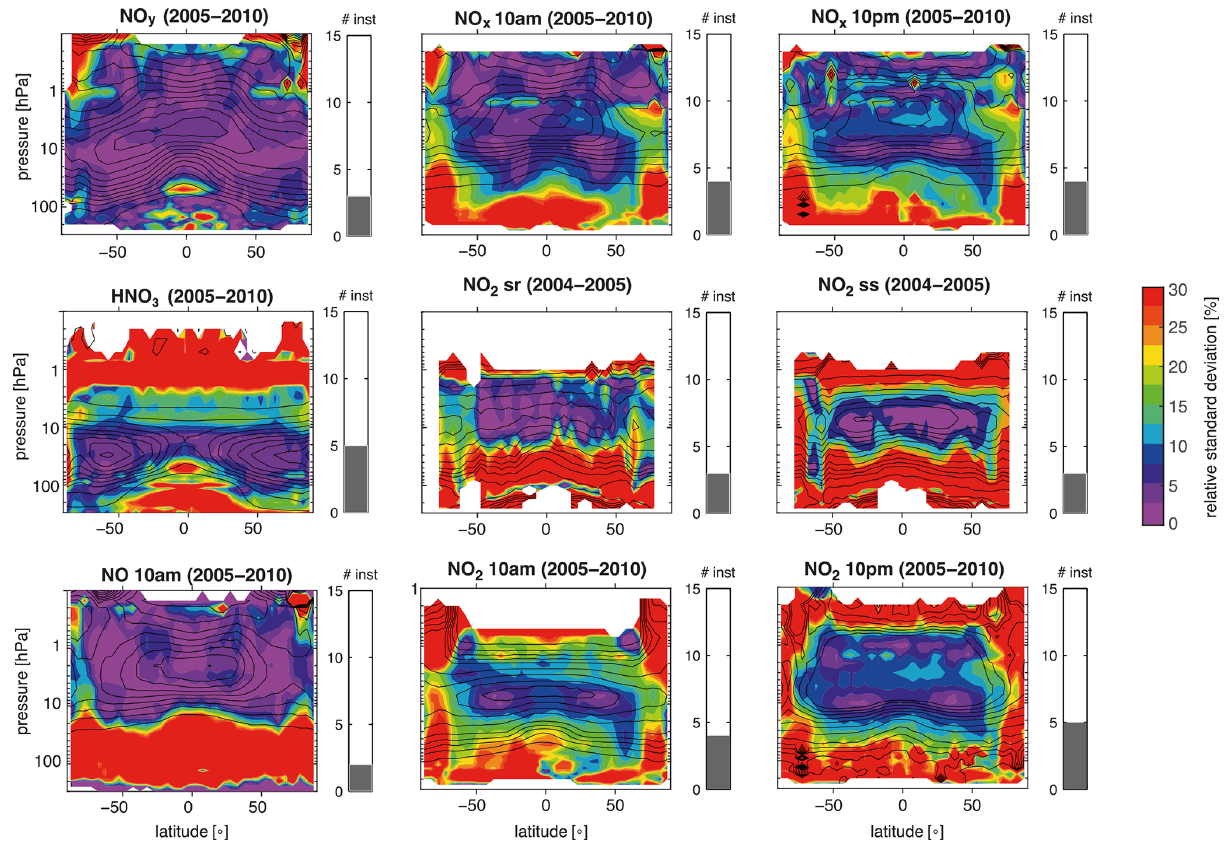
Figure 16. Same as Fig. 14 but for nitrogen-containing species. The assessment of the uncertainty in the annual mean state of NO, NO x , and NO 2 is based on gridded datasets corresponding to 10:00 and 22:00LT, and for the latter also on datasets corresponding to local sunrise (sr) and local sunset (ss). Note that some of the included datasets have been derived by scaling the individual measurements with a chemical box model to 10:00 and 22:00 local solar time (LST). See SPARC (2017) for more detailed information. Reactive nitrogen (NO x ) is here defined as NO + NO 2 . The odd nitrogen family (NO y ) is defined as NO x + HNO 3 + 2 × N 2 O 5 + ClONO 2 + HNO 4 . For N 2 O 5 , ClONO 2 , and HNO 4 , an assessment of the uncertainty in the annual mean field cannot be provided since no data products at the same local solar time are